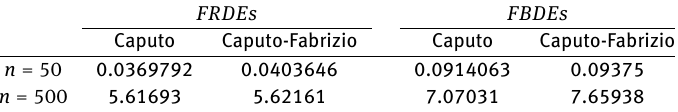
Table 5: Duration used in